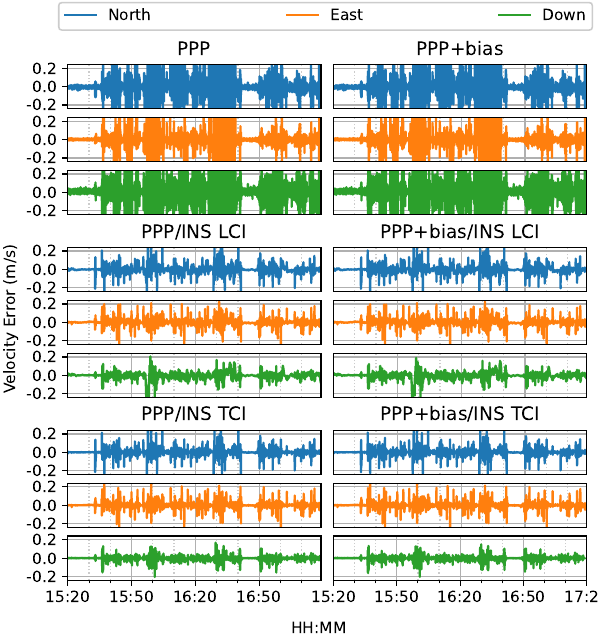
Figure 31. Real-time GPS/Galileo PPP/INS velocity errors of city center test on 27 January 2022 with respect to IE RTK/INS TCI